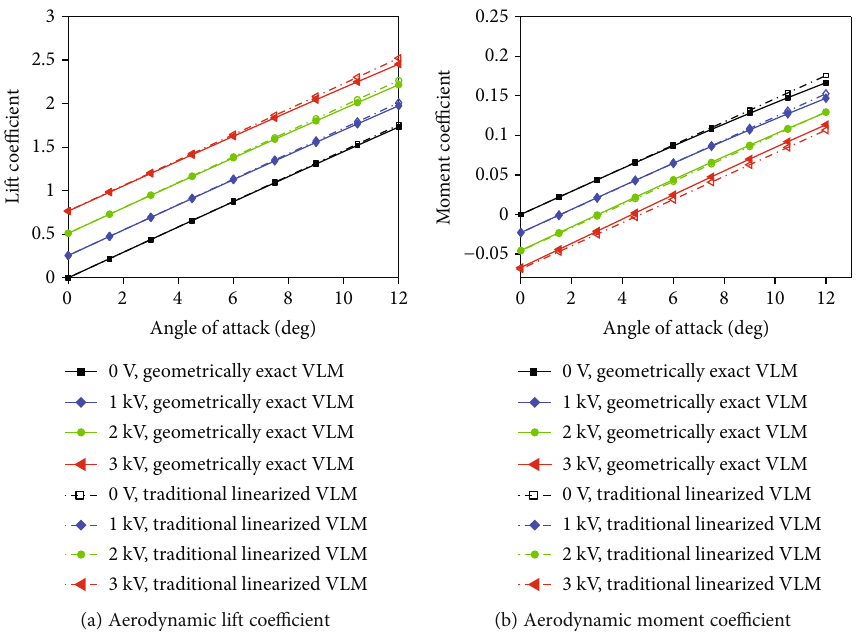
Figure 4: E ff ect of angle of attack and driving voltages on aerodynamic coe ffi